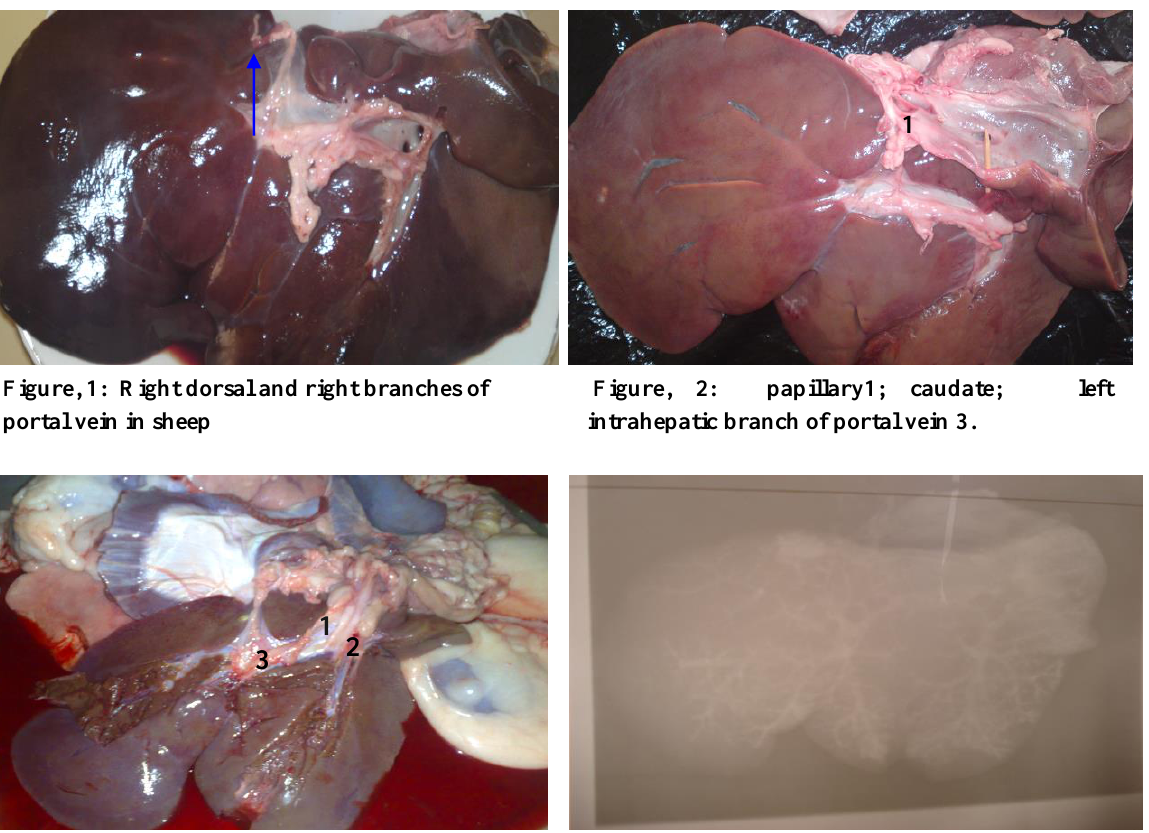
Figure 4: X-Ray image of hepatic vein (1);caudal vein (2); , Figure, 3: Portal vein (1): dorsal vein (2) and left papillary right dorsal branch of portal vein in sheep.